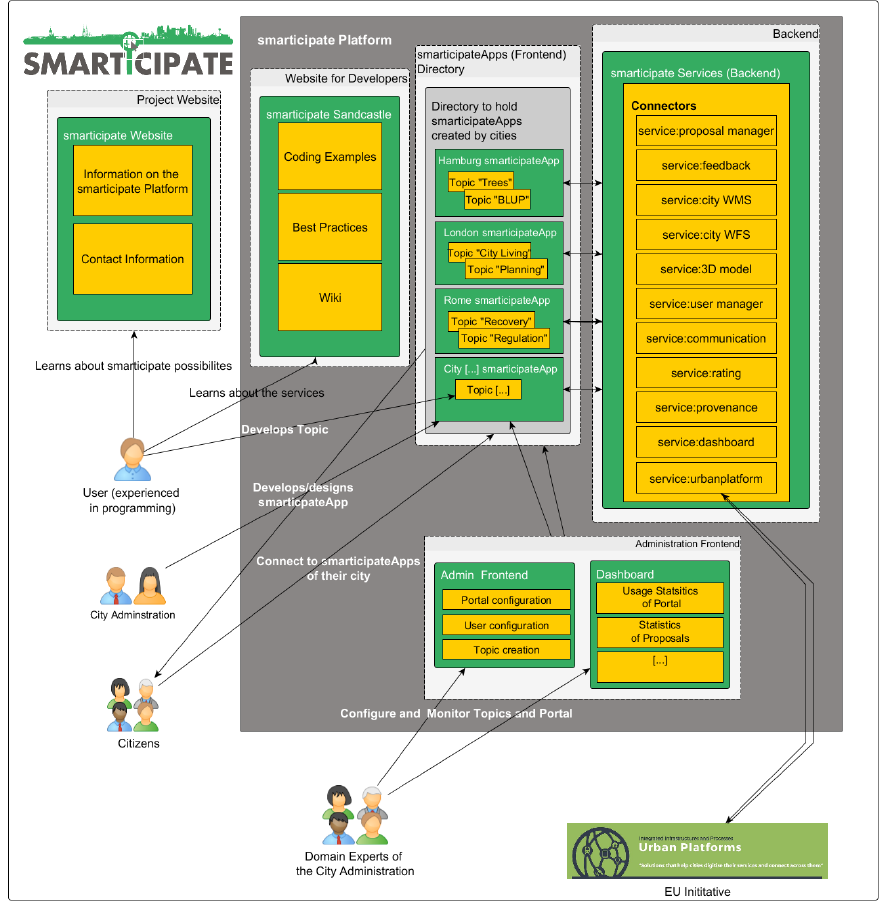
Figure 6. Smarticipate system architecture.